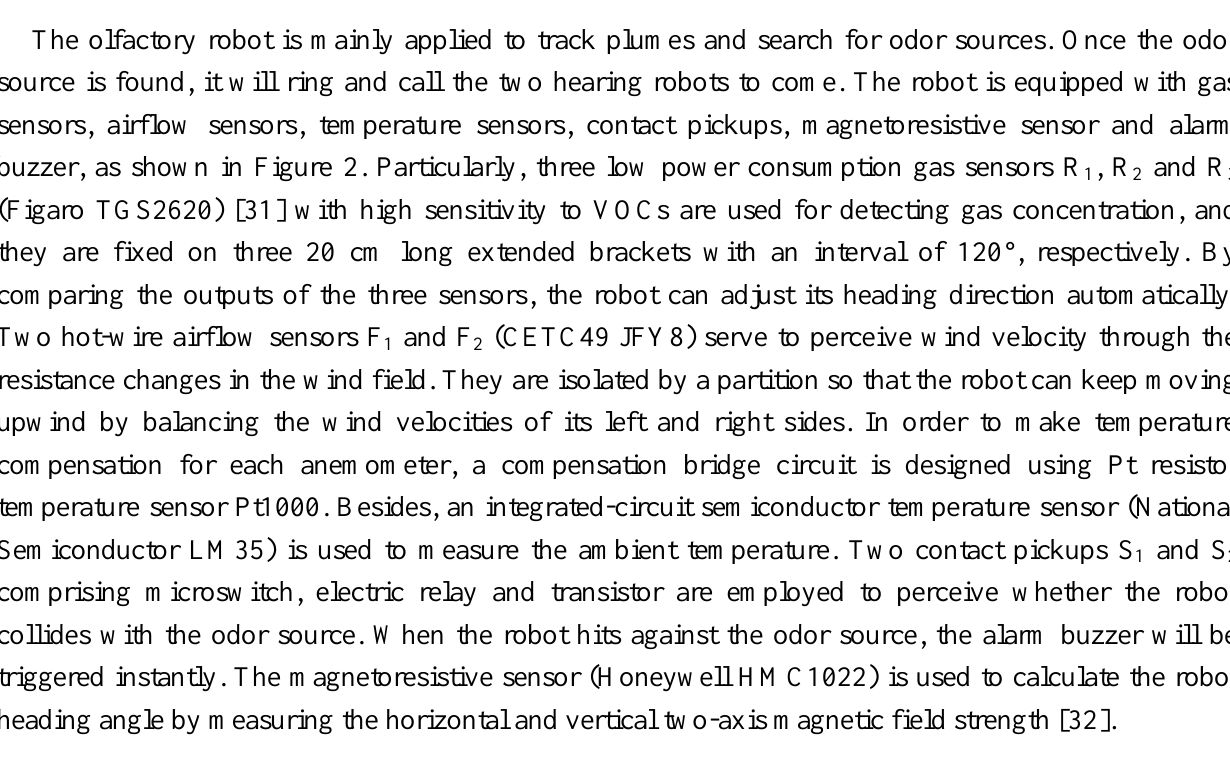
Figure 2. Photograph of olfactory